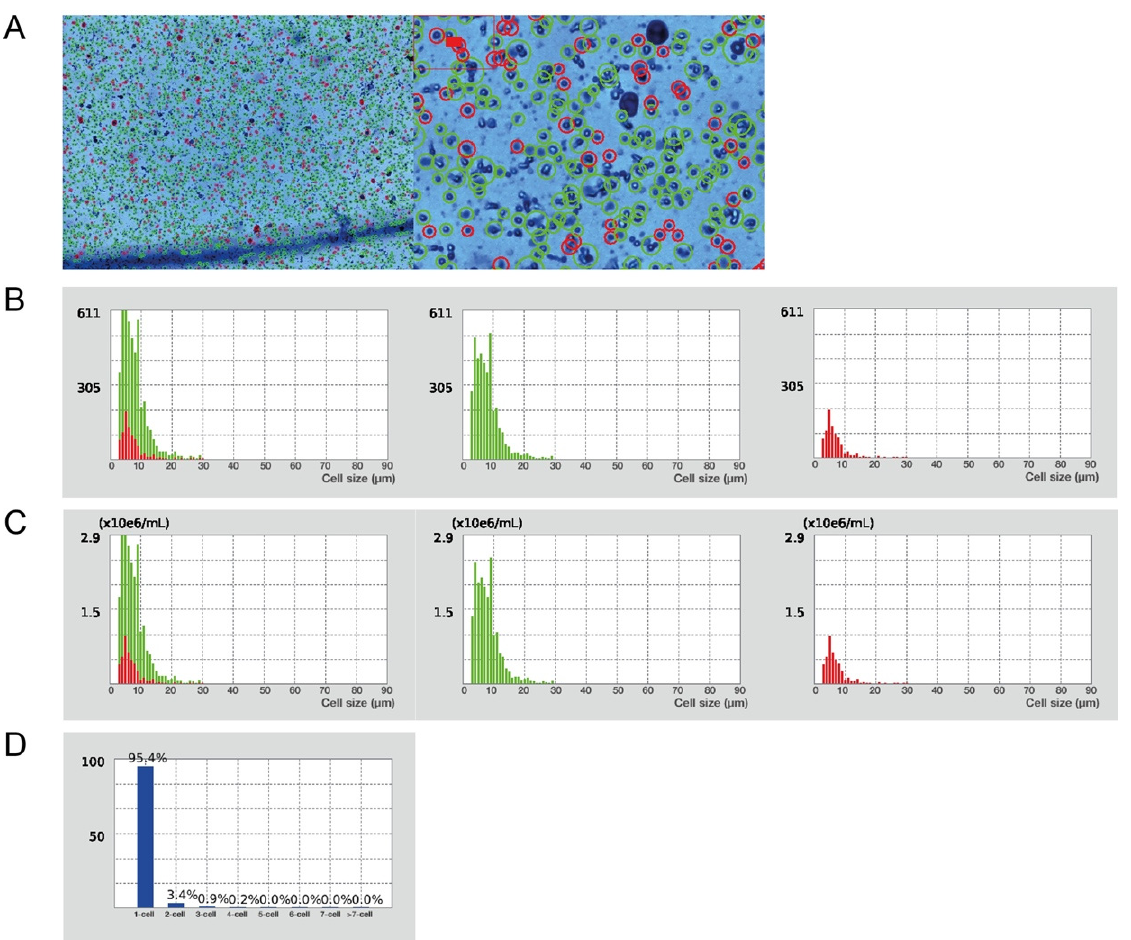
Figure 4. Characteristics of the obtained single cell suspension. ( A ) Evaluation of cell viability and total cell concentration (Trypan Blue stain, 1 × and 4 × magnification in Luna cell counter). Green circles represent live cells (82%); red circles dead cells (18%). Total yield of 2.2 × 10 7 live cells/mL from 1 g of liver tissue. ( B ) Cell size distribution by cell number. Green histograms represent live cells; red histograms represent dead cells. ( C ) Cell size distribution by cell concentration. Green histograms—live cells; red histograms—dead cells. ( D ) Cell cluster map.